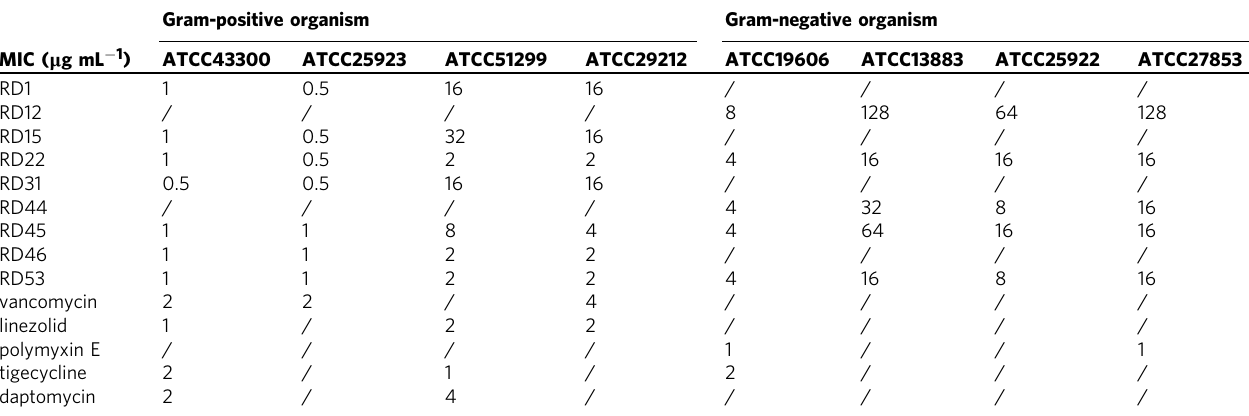
Table 1 Antimicrobial activity of selected RD dyes against four Gram-positive and four Gram-negative bacteria